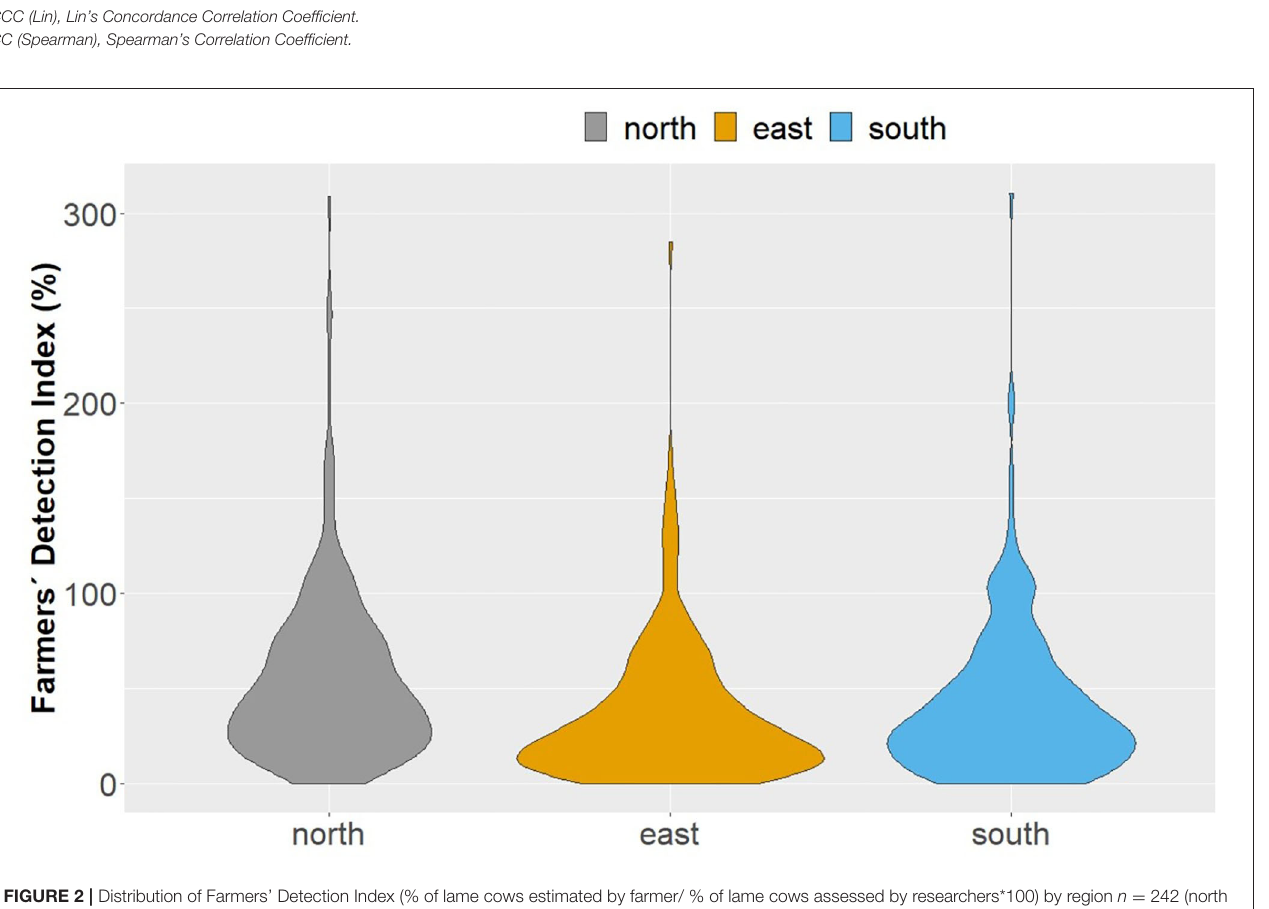
FIGURE 2 | Distribution of Farmers’ Detection Index (% of lame cows estimated by farmer/ % of lame cows assessed by researchers*100) by region n = 242 (north and east), n = 237